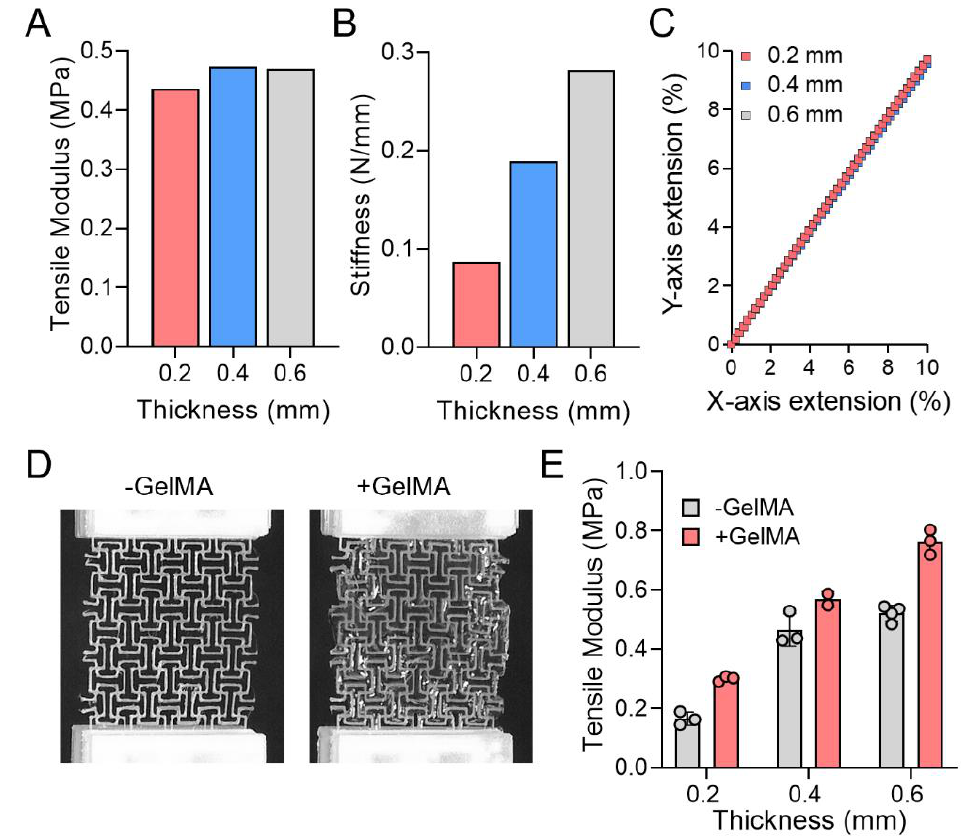
Figure 2. Mechanical properties analysis of orthogonal missing rib substrates according to the different thicknesses and GelMA application. ( A ) Tensile modulus of missing rib substrates by thickness; ( B ) Stiffness and ( C ) X vs. Y extension curves of missing rib substrates by thickness. ( D ) Tensile test and ( E ) modulus of missing rib substrates with and without GelMA application. Mean ± SD.